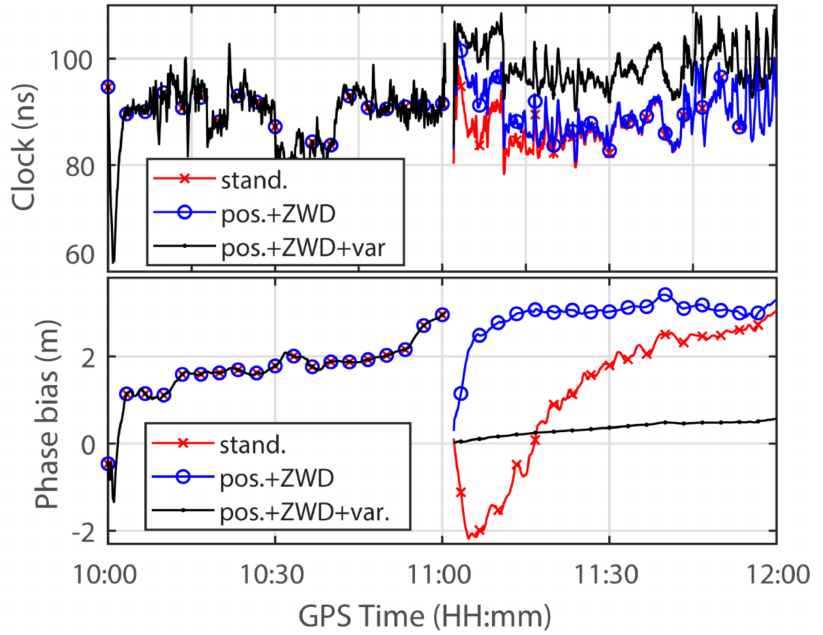
Figure 8. Receiver clock offset and GPS PRN 11 phase bias time series for standard PPP (red line cross marks), position- and ZWD-constrained PPP with initialized variance (blue line with cycle marks), as well as position- and ZWD-constrained PPP with inherited variance from prior estimations before the gap (black line with solid